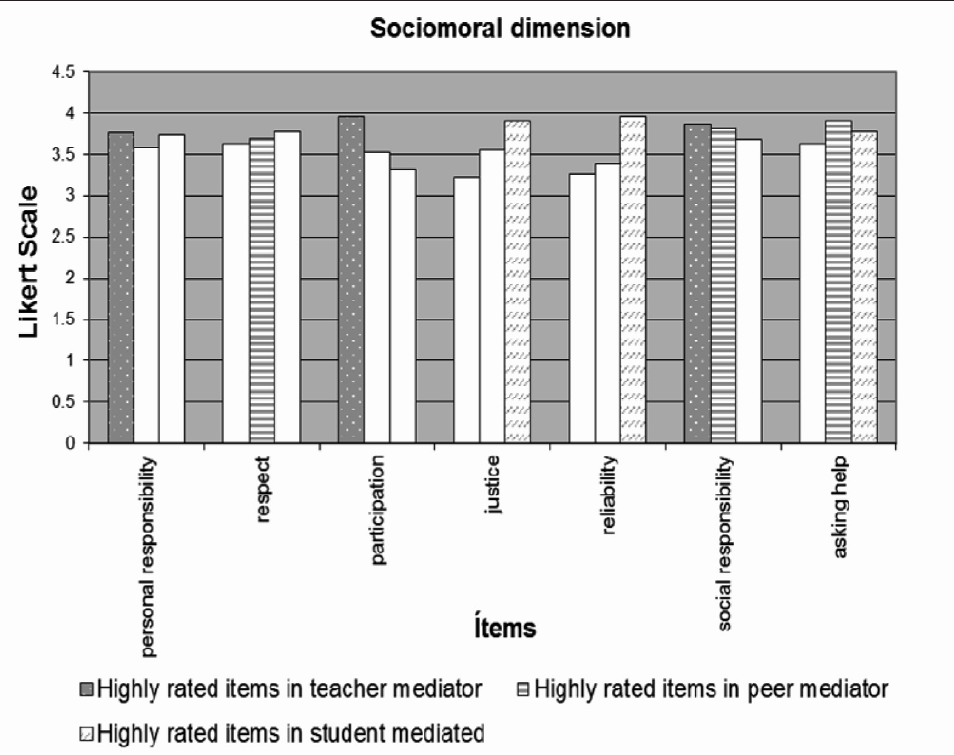
Figure 1: The distribution of scores for socio-moral learning